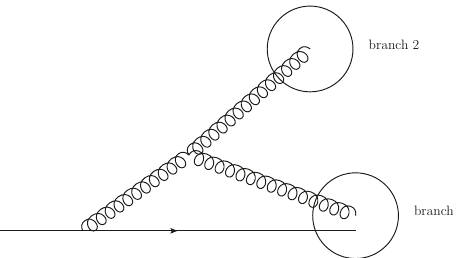
. The two gluons cut